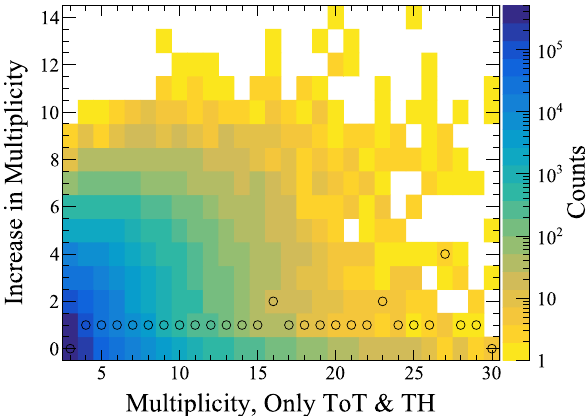
Fig. 3 The increase in station multiplicity when including the ToTd and MoPS triggers versus the original multiplicity with only ToT and TH. The black circles show the median increase in that multiplicity bin